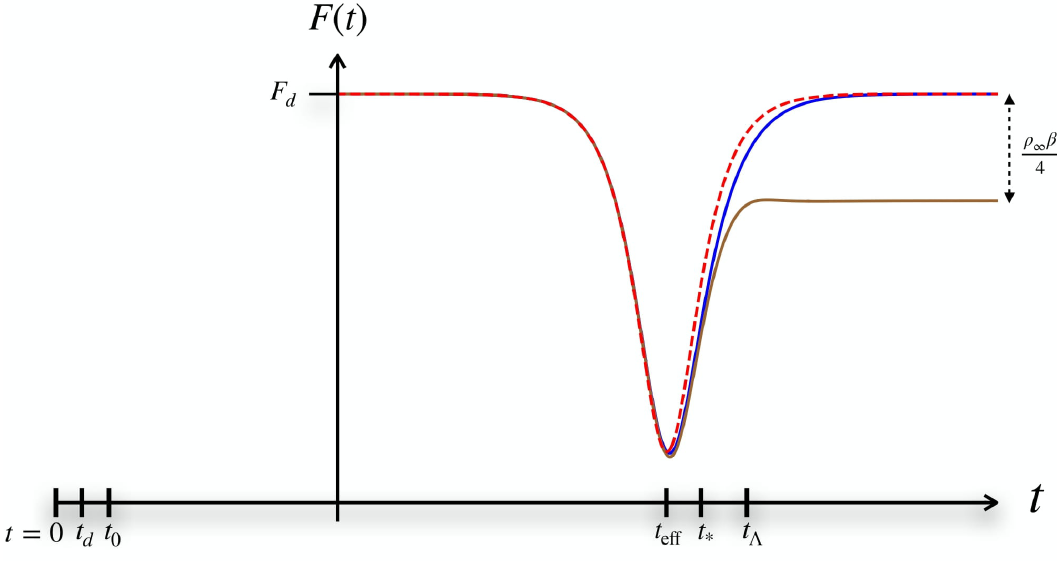
Figure 2 . Extremal chaos in physical systems. The extremally chaotic OTOC (dashed red) is non- analytic on the boundary: Im t = ± β/ 4 . This non-analyticity can be removed by a standard i(cid:15) -shift. The associated regularized OTOC, which is shown in blue, differs only slightly from the unregularized − 2 π t OTOC. However, a late-time long-tailed correction to the density function ρ ( t > t ) = ρ β ∞ e Λ does change the asymptotic behavior of the OTOC (shown in brown). Various relevant time scales are also shown in the figure: t = dissipation time ∼ β , t = factorization time, t = effective (or a d 0 eff gap) time scale, t = scrambling time, and t is a cut-off scale above which late-time corrections ∗ Λ > t ∗ can become important. In the presence of a late-time long-tailed correction, a physical system can be extremally chaotic only approximately up to the cut-off scale t Λ